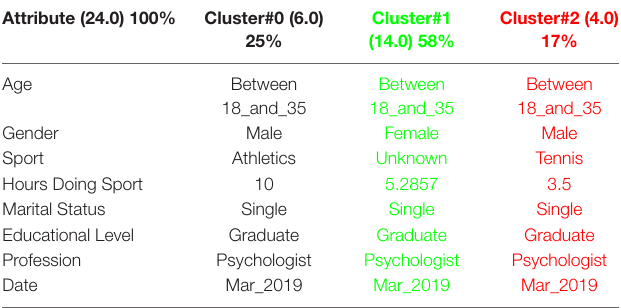
TABLE 3 | 3 clusters STAI analysis for March to May 2019.